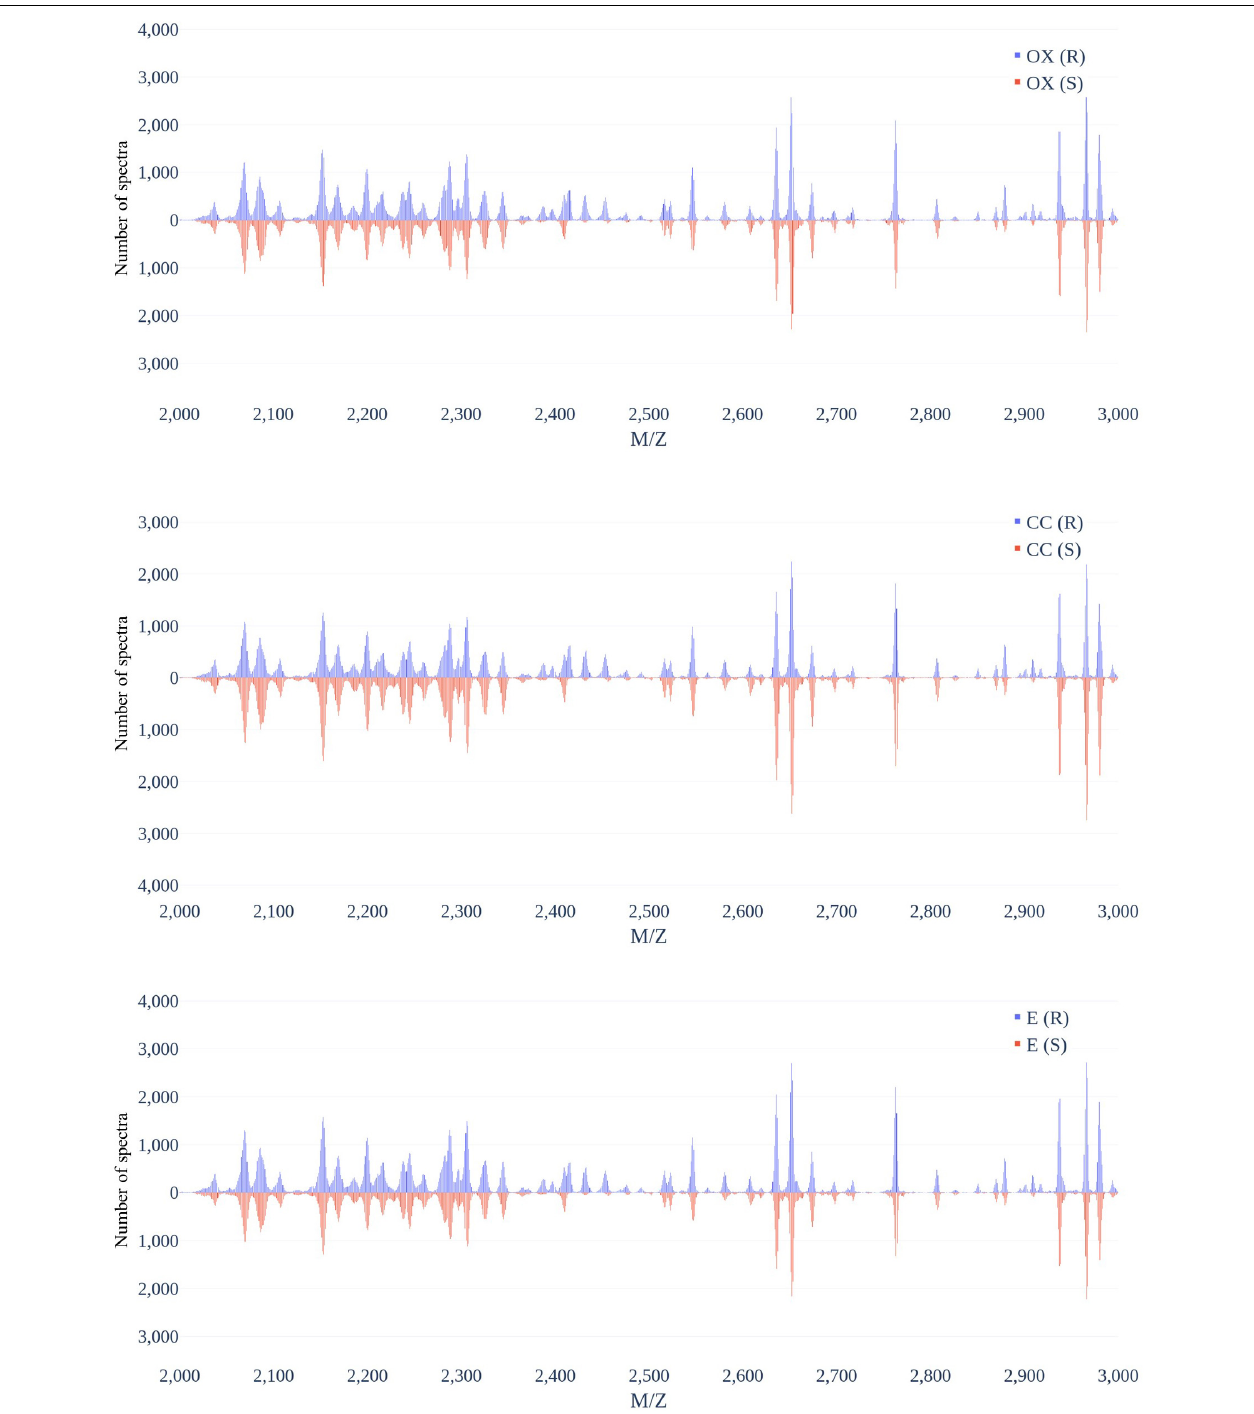
FIGURE 4 | Distribution of number of spectra that were derived from oxacillin- (upper), clindamycin- (middle), and erythromycin-resistant/susceptible (bottom) Staphylococcus aureus isolates at M/Z = 2,000–3,000.